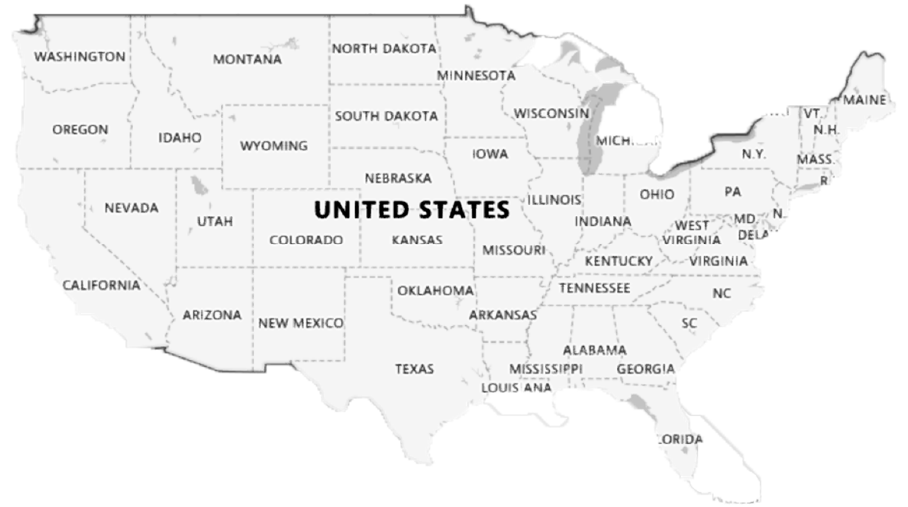
Figure 1. The study area map (source: Google Maps).